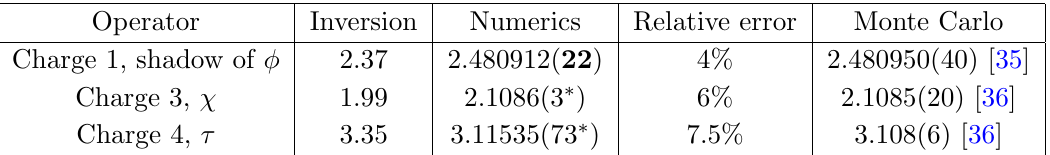
(cid:12) (cid:12) (cid:12) numerics (cid:0) inversion (cid:12) . The charge 1, 3, and 4 inversion formula numerics , [ (cid:30)t ] 3 , and [ (cid:30)(cid:31) ] 4 trajectories at spin 0. We also include 0 0 0